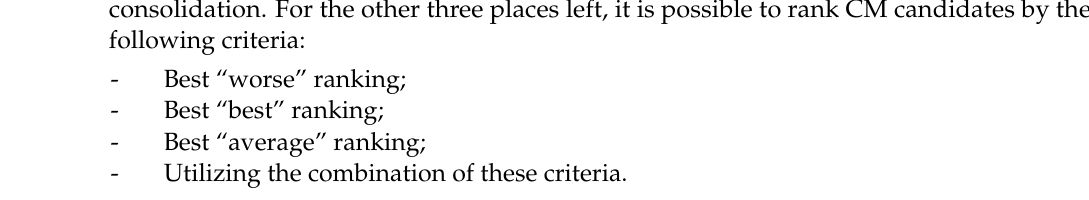
Table 10. Ranking lists and standard deviations of alternative ranks with eight criteria.